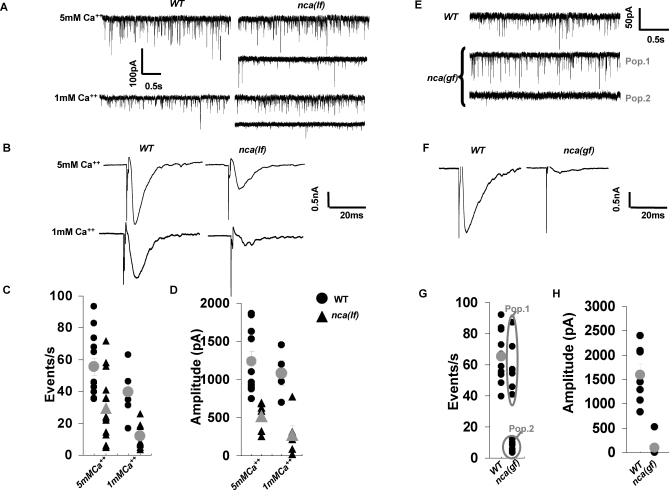
NCA-1 Activity Is Required for Normal Synaptic Transmission at NMJsRepresentative traces of spontaneous activity [(A) for nca(lf) and (E) for nca(gf)] and responses evoked in muscle by an electric stimulation of the ventral nerve cord [(B) for nca(lf) and (F) for nca(gf)] are shown.(A–D) The nca(lf) mutant mPSCs varied between wild-type (WT) values (nca(lf), upper trace) and decreased frequency and amplitude (nca(lf), lower trace). The overall mPSC frequency (C) and evoked response amplitude (D) were decreased in nca(lf) animals as compared to wild-type at either 5 mM (nca(lf): n = 15; WT: n = 13) or 1 mM (nca(lf): n = 9; WT: n = 6) extracellular Ca2+. No significant change in mPSC amplitude and distribution was observed between nca(lf) and WT animals. Individual results are shown in black, mean ± SEM in gray, for recordings at 5 mM and 1 mM extracellular Ca2+.(E–H) Representative traces of spontaneous (E) and evoked (F) post-synaptic currents at the neuromuscular junction at 5 mM Ca2+. The nca(gf) mutant mPSCs were either comparable to WT (population 1) or highly decreased in frequency and amplitude (population 2), whereas highly reduced (if any) responses could be evoked by electric stimulation of the nerve cord (F). The mPSC frequency (G) and evoked responses amplitude (H) are plotted for N2 and nca(gf) animals. Individual results are shown in black, mean ± SEM in gray, when relevant. (WT, mPSCP, n = 10, ePSP, n = 7; nca(gf), mPSP, n = 13, ePSP, n = 8) Error bars: SEM, *p ≤ 0.05, **p < 0.01. Statistic analysis was performed with Student's t-test.